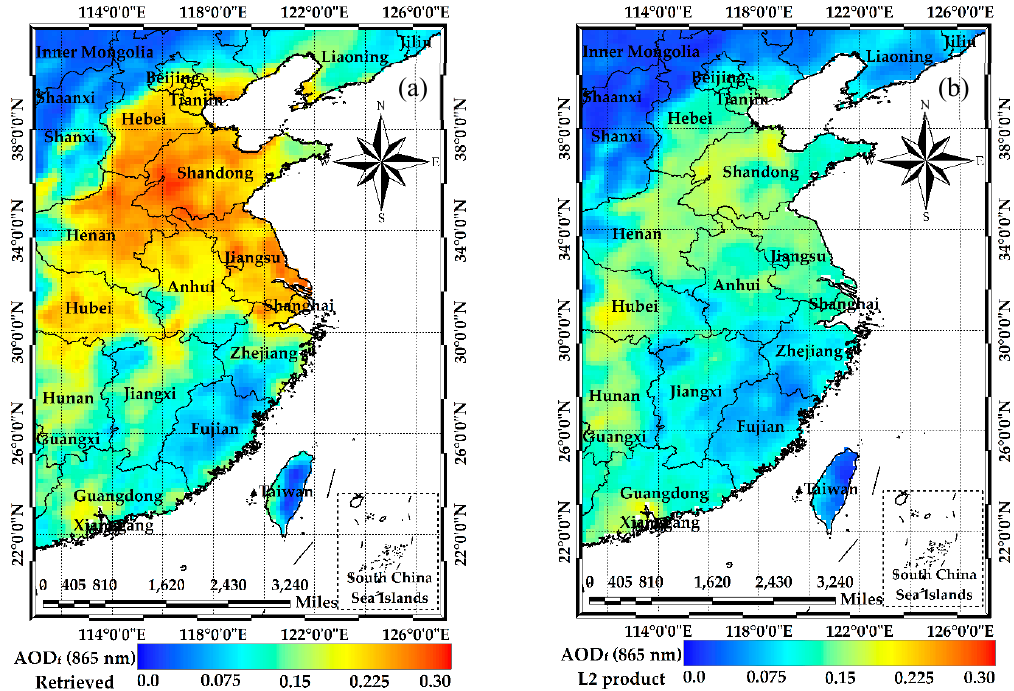
Figure 9. The comparison of the 2012 year-mean AOD f retrieval results. (a) is the result of this work and (b) is the result of PARASOL product.